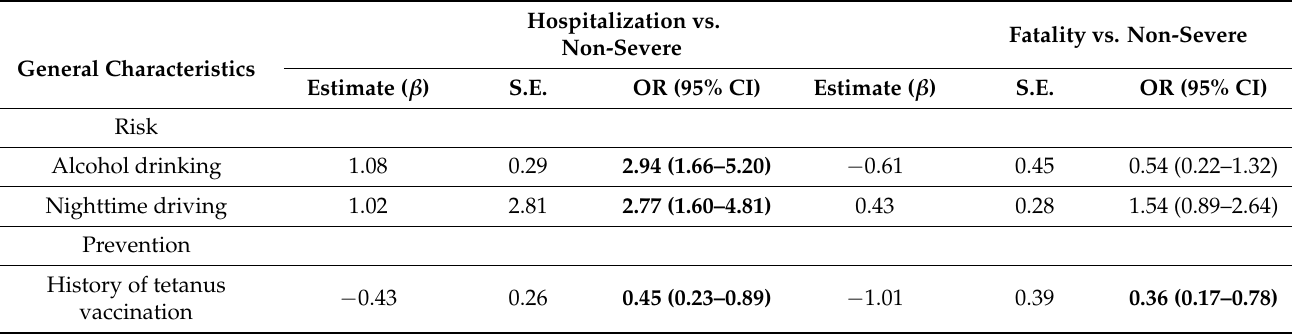
Table 3. Crude odds ratio (OR) for each factor comparing levels of outcome severity at the Burapha University Hospital emergency